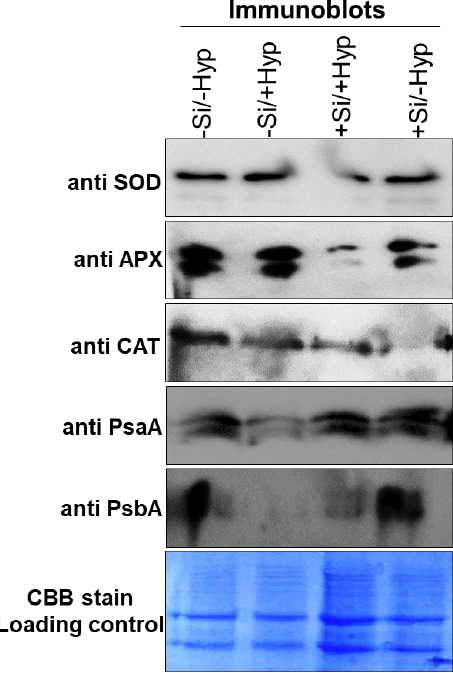
Figure 5. Immunoblots of superoxide dismutase (SOD), ascorbate peroxidase (APX), catalase (CAT), PsaA, and PsbA under hyperhydricity and silicon (Si) treatments (−Si/−Hyperhydricity; PsaA, and PsbA under hyperhydricity and silicon (Si) treatments ( − Si/ − Hyperhydricity; −Si/+Hyperhydricity; +Si/+Hyperhydricity; +Si/−Hyperhydricity) in shoot cultures of carnation − Si/+Hyperhydricity; +Si/+Hyperhydricity; +Si/ − Hyperhydricity) in shoot cultures of carnation ( Dianthus caryophyllus L.) grown in vitro . ( Dianthus caryophyllus L.) grown in